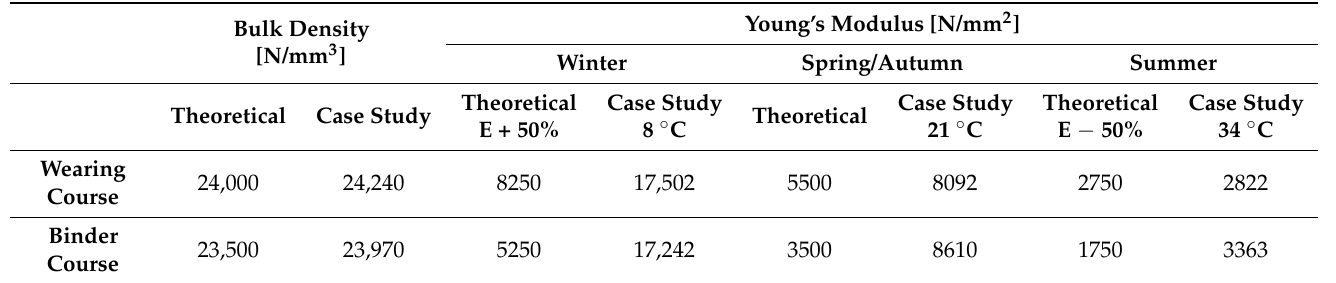
Table 4. Key characteristics of asphalt layers considering theoretical assessment and case study.